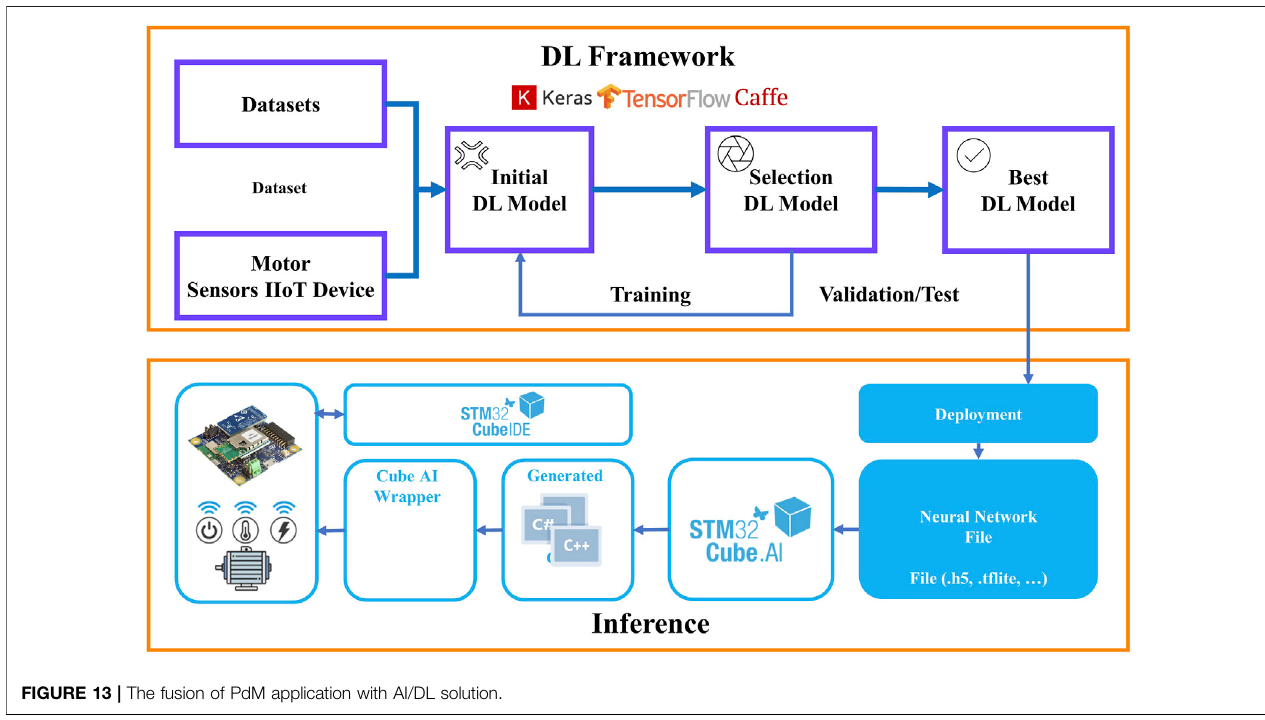
FIGURE 13 | The fusion of PdM application with AI/DL solution.